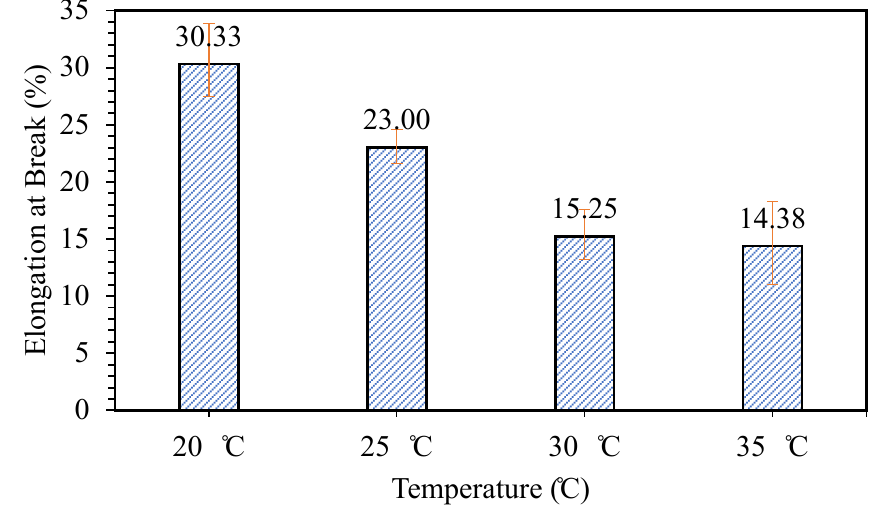
Figure 7. Elongation at break of patches prepared at different mixing temperatures.